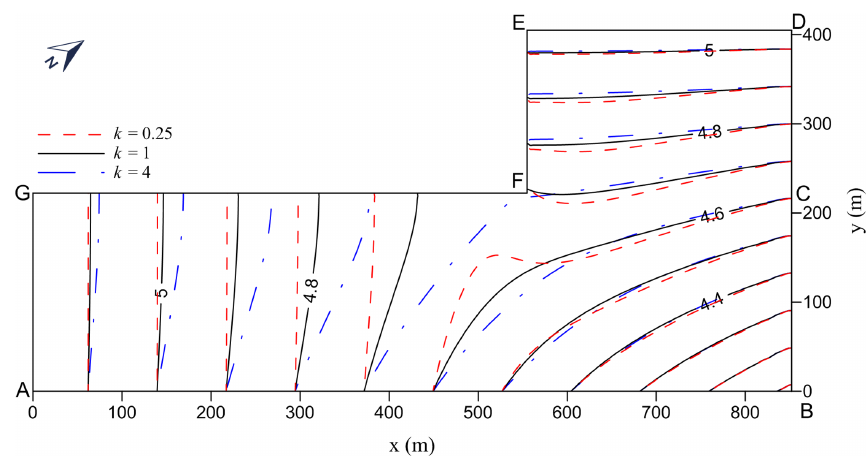
Figure 5. Steady-state hydraulic head contours in the L-shaped aquifers with three different anisotropy ratios for κ 1 = κ 2 = κ .